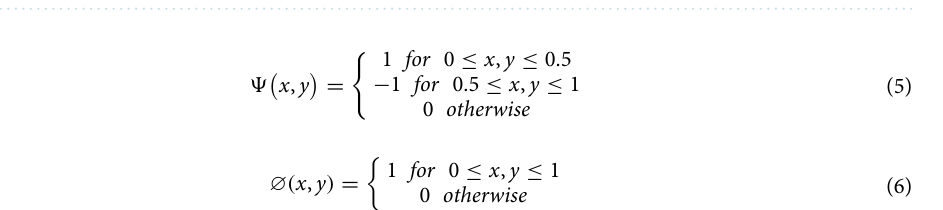
Figure 3. Illustration of subbands of coefficients formed after n-level application of wavelet decomposition